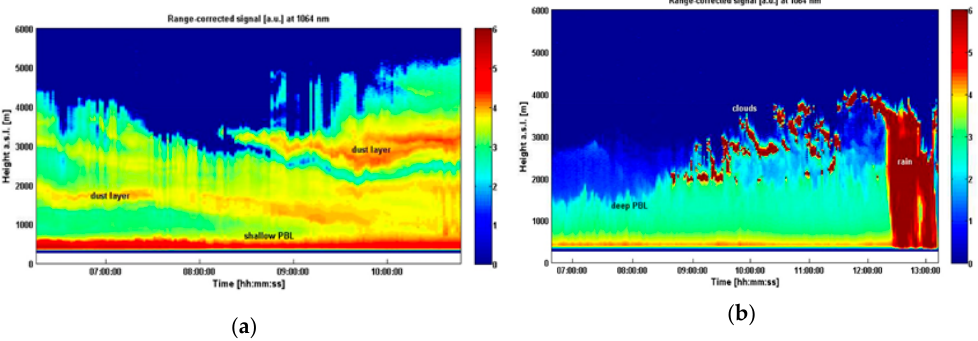
Figure 5. Collocated EOLE Raman lidar measurements (1064 nm) for June 18 ( a ) and June 20 ( b ) denoting the PBL structure and the presence/absence of aerosols and